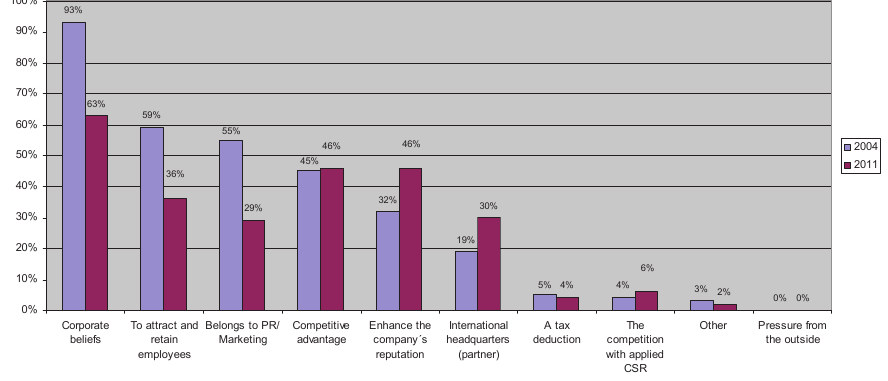
Fig. 1 - Motivation for CSR. Source: Trnková (2004).